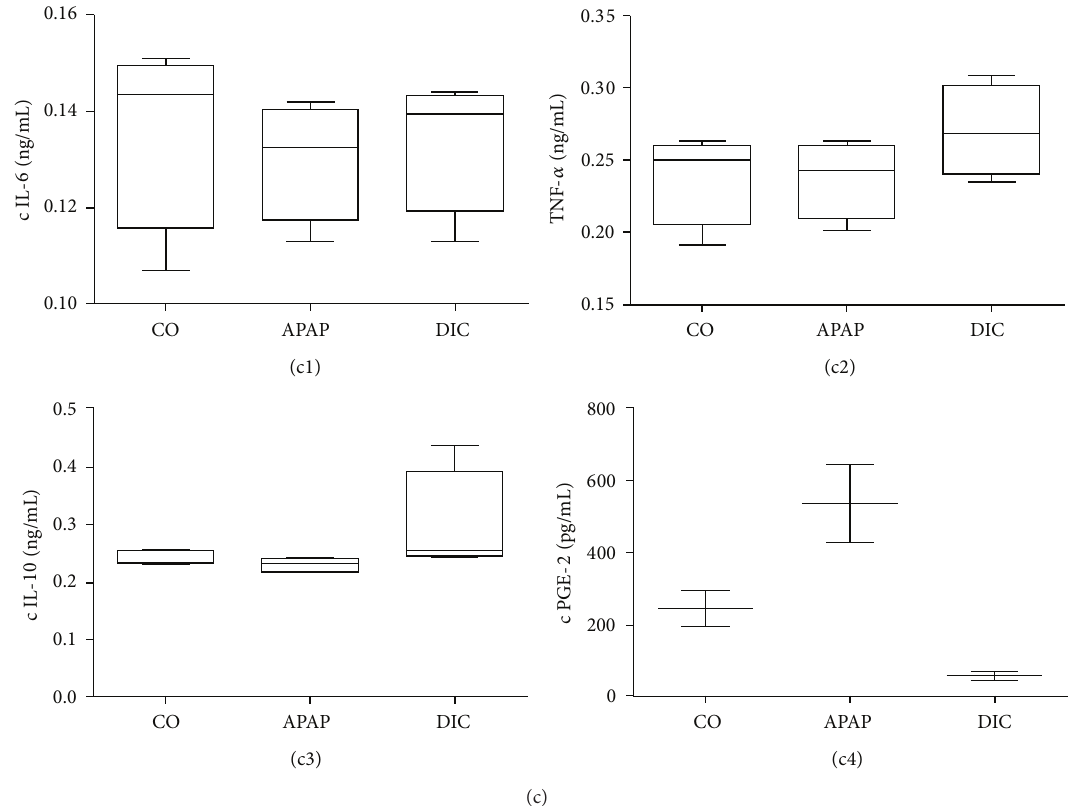
Figure 6: Secreted cytokine profiles of KC activated with supernatants of PHH previously incubated with subtoxic concentrations of hepatotoxic drugs . PHH from three donors (A, B, and C; see Table 1) were treated with 100 𝜇 M acetaminophen (APAP) or 100 𝜇 M diclofenac (DIC) for 1h. The supernatants were used to stimulate KC from the same donor for 2h. Inflammatory reactions of KC due to hepatocyte stress/damage were determined by cytokine analysis in KC supernatants. IL-6 ((a1), (b1), and (c1)), TNF-alpha ((a2), (b2), and (c2)), IL-10 ((a3), (b3), and (c3)), and PGE-2 ((a4), (b4), and (c4)) were investigated using cytokine ELISAs. Data are shown as box plots, representing the median, the = 4 𝑛 = 2 interquartile range, and minimum and maximum values, 𝑛 ( IL-6,TNF-alpha,IL-10) (PGE-2)